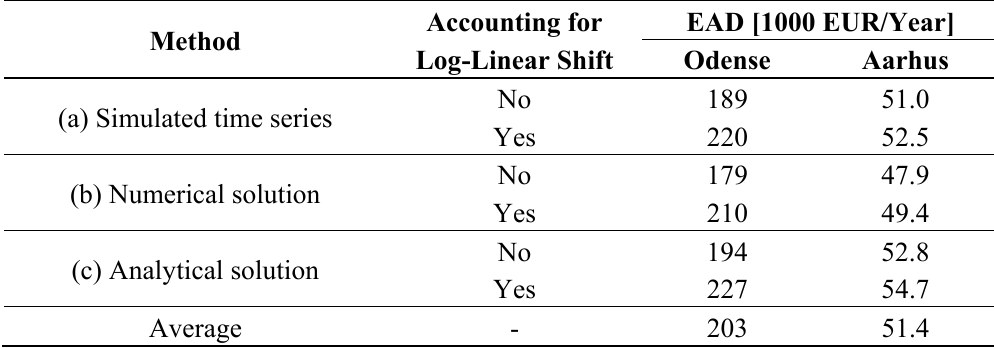
Table 4. Overview of the resulting EAD based on the calculation method